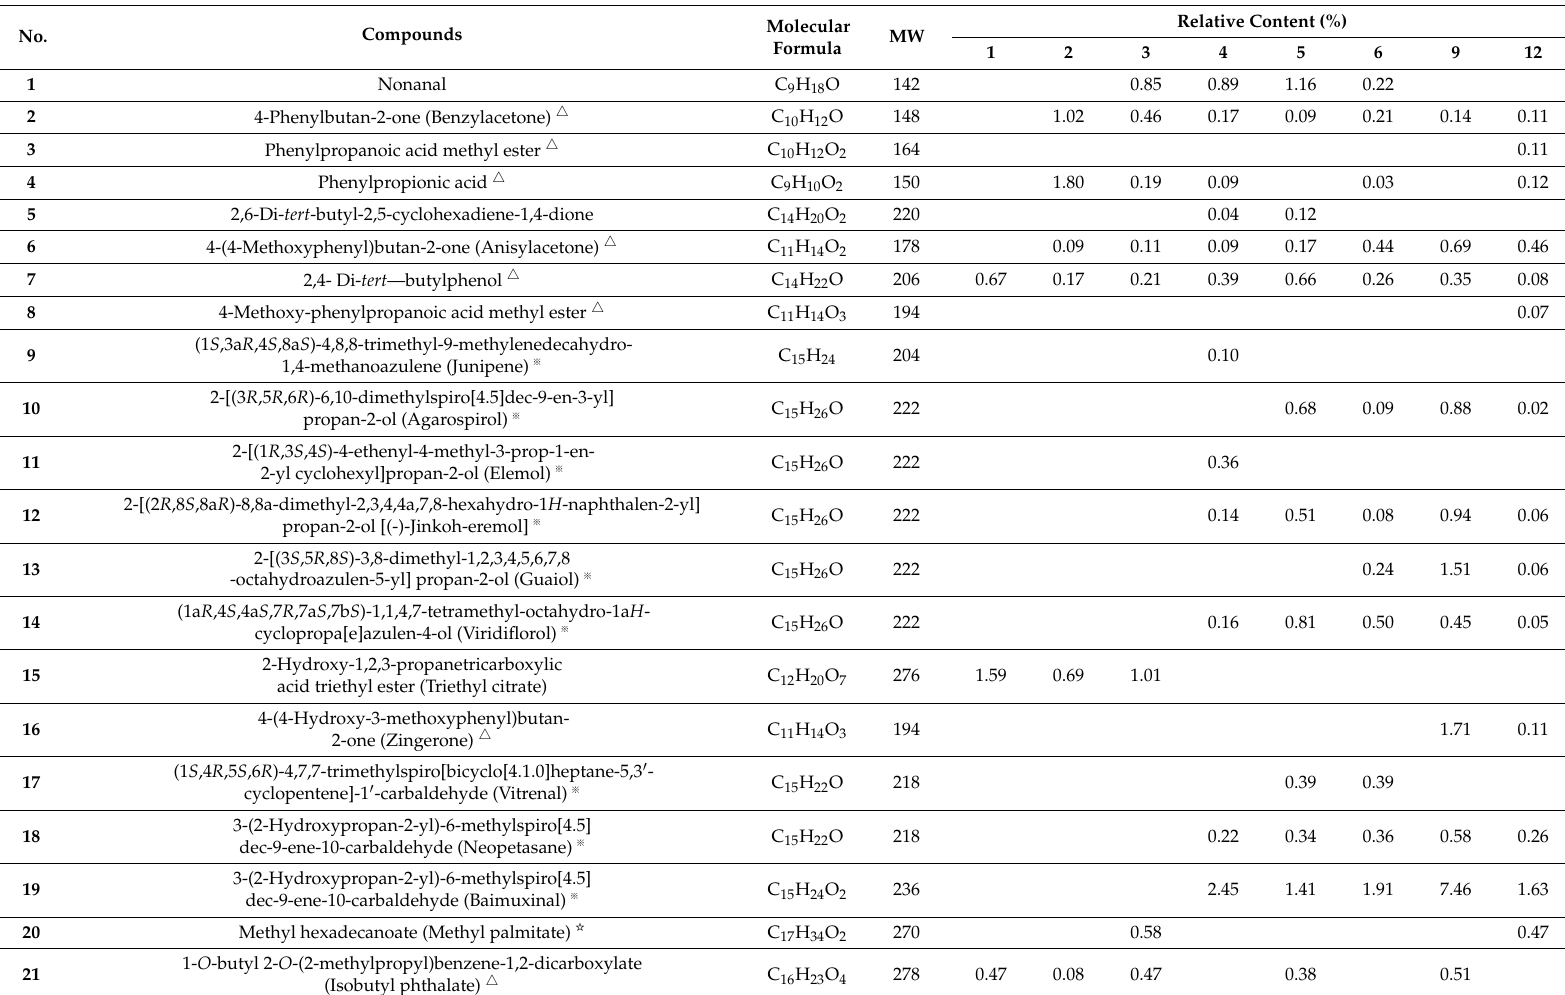
Table 1. Volatile constituents of agarwood samples produced from the 1st to 12th months.